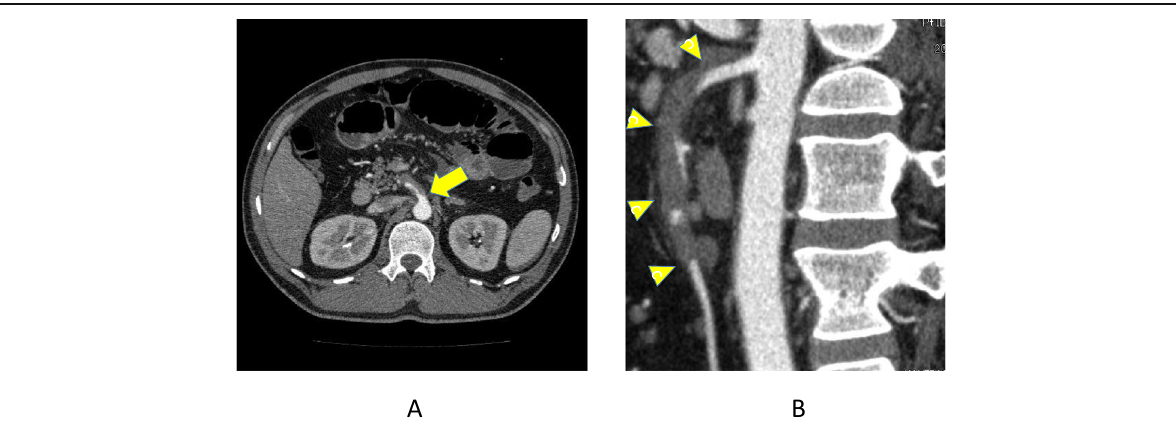
Fig. 1 Computed tomography images 4 days after the symptom onset. a The main trunk of the superior mesenteric artery was dissected from its origin (arrow). b Sagittal multiplanar reconstruction computed tomography showed the thrombosed false lumen and compressed true lumen with thrombosis at the distal portion (arrowheads) and enhancement at the more distal portion